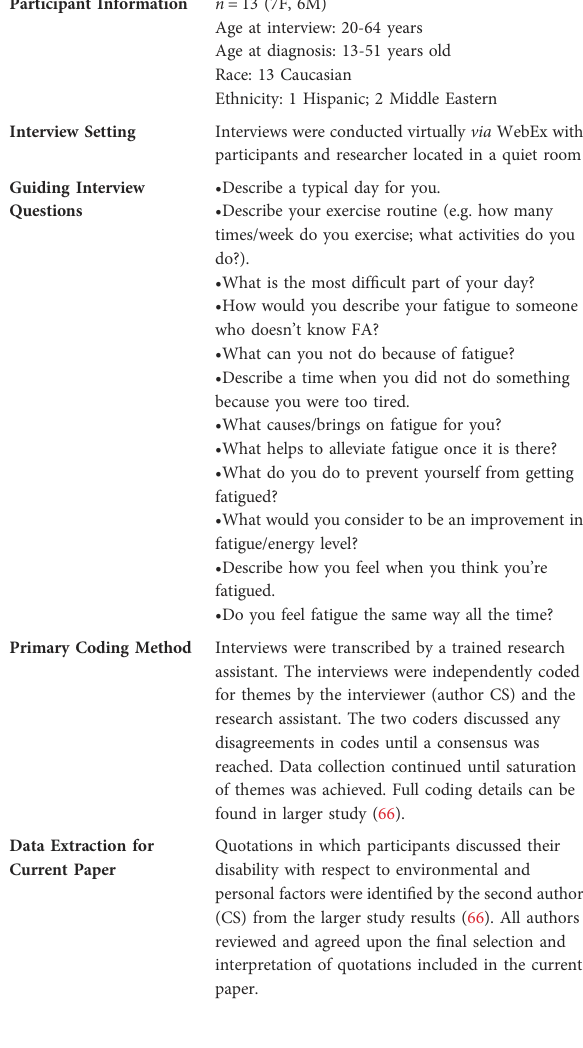
TABLE 1 Overview of phenomenological